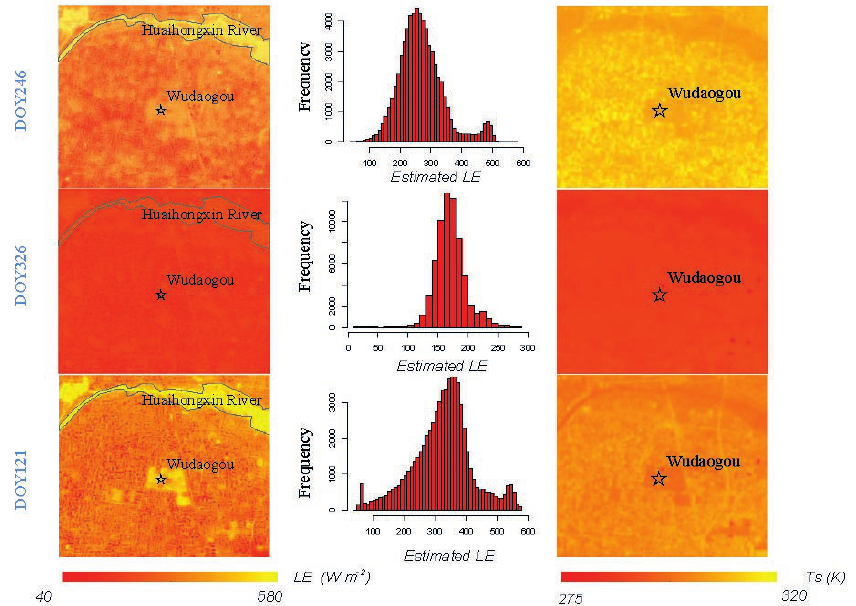
Fig. 4 Spatial distribution of LE (left column), histogram of LE (middle column) and spatial distribution of t s (right column) in three dates: DOY246 in 2013, 326 in 2013, 121 in 2014; the pentagram represents the location of the observation